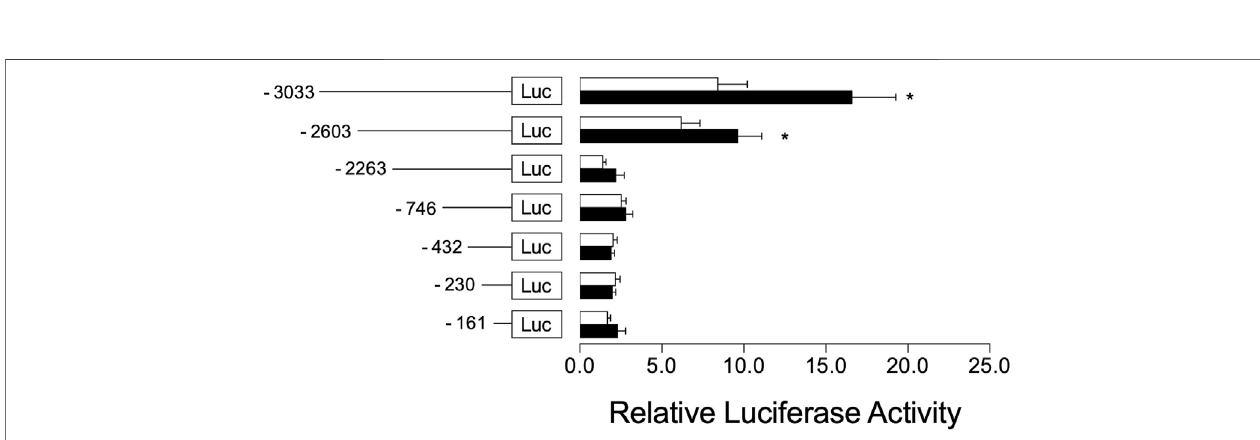
FIGURE 7 | Putative CAR responsive DR-4 elements in the Cyp2a5-3,033 + 10-luc promoter construct. Two potential CAR-responsive DR-4 elements identi fi ed within the Cyp2a5-3,033 + 10-luc construct through MatInspector analysis. Core sequences are shown below each site.